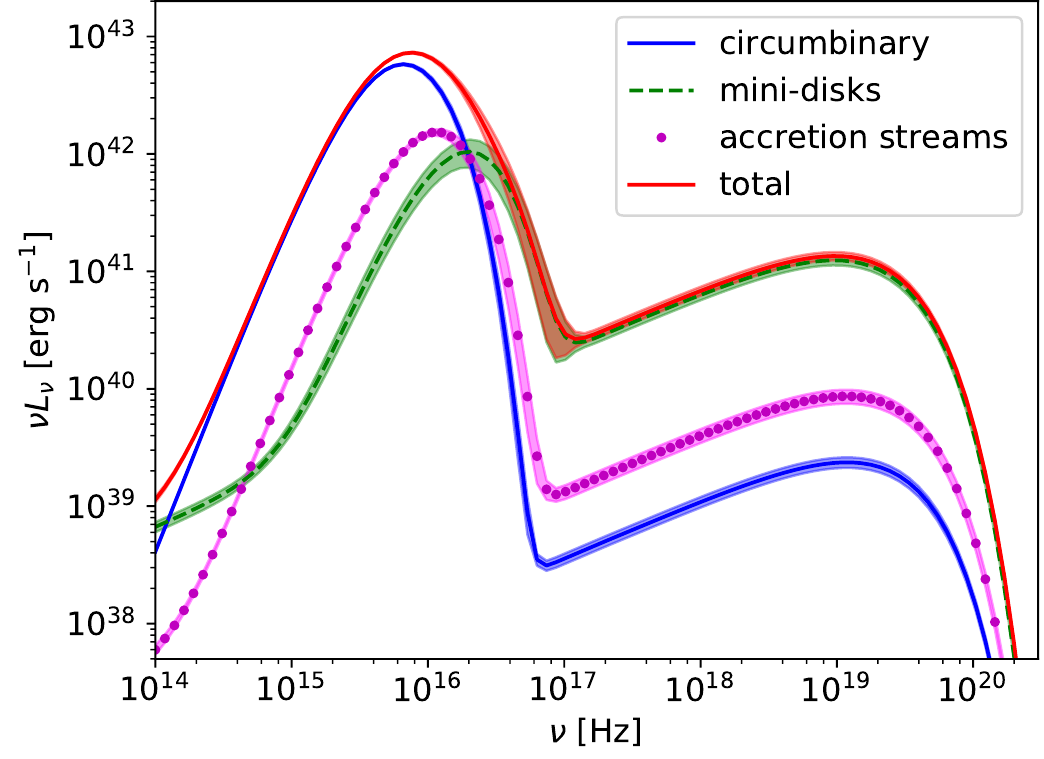
Figure 4. Different components from the various disks present in the system of [74] contributing to the spectrum. Mini disks reveal their emission at higher energies whereas emission from the circumbinary disk at larger radii contributes more at lower frequency. Emission from the accretion streams falls in the middle of these two regimes and based on this analysis may be difficult to distinguish from the other